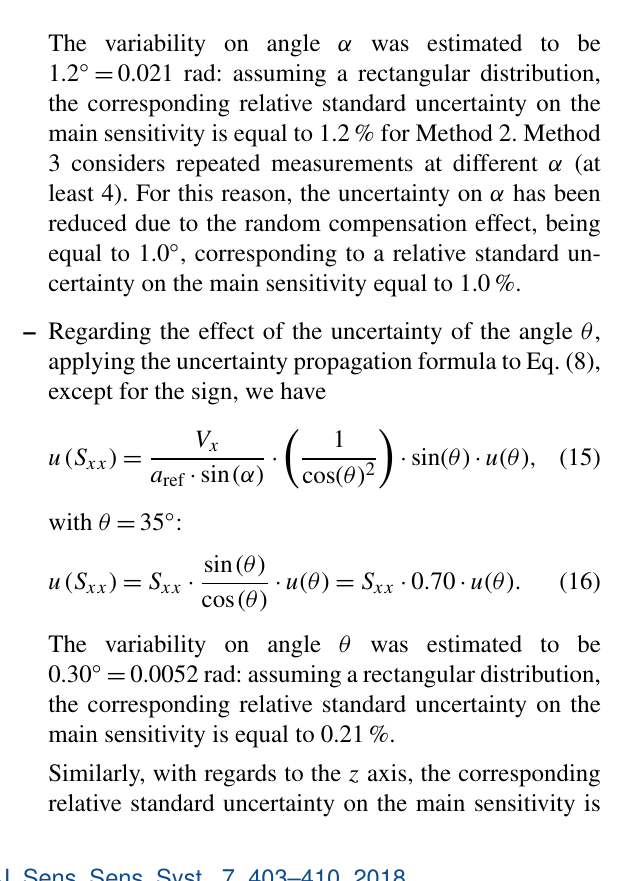
Table 1. Uncertainty budget. Source of the